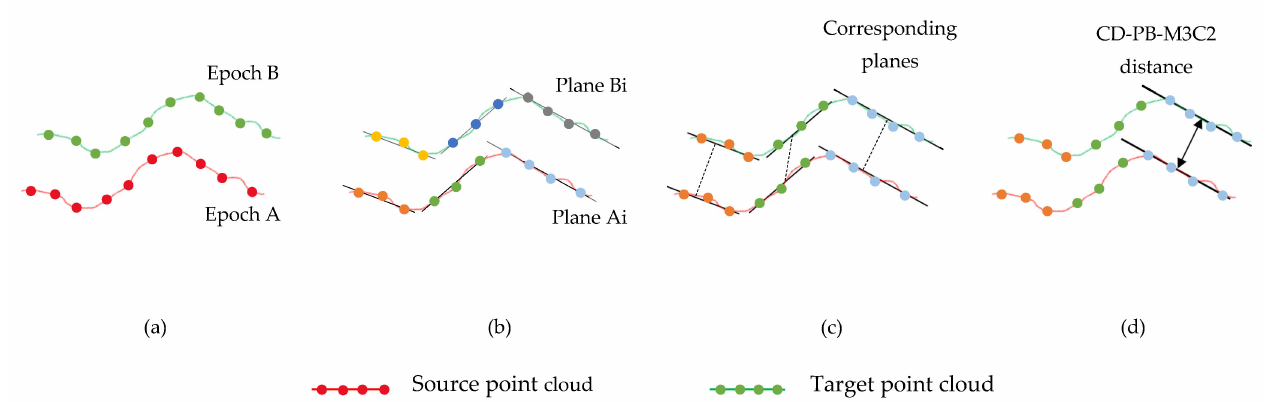
Figure 5. Correspondence-driven plane-based M3C2 as described in [131]. ( a ) Input point clouds. ( b ) Extraction of planar surfaces. ( c ) Plane correspondence search. ( d ) Quantification of change and uncertainty.